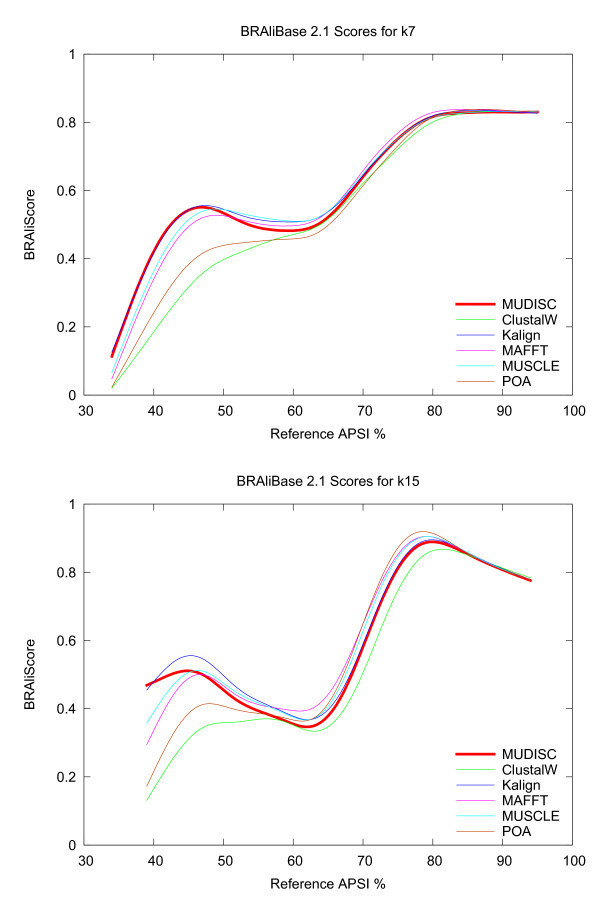
Alignment quality on the BRAliBase data set. MUDISC (the new method) is compared with several alignment programs on a seven (k7) and fifteen (k15) sequence RNA reference set from BRAliBase 2.1. A higher score indicates better quality and is shown in relation to the average pairwise sequence identity (APSI). MUDISC uses discrete profile alignment.